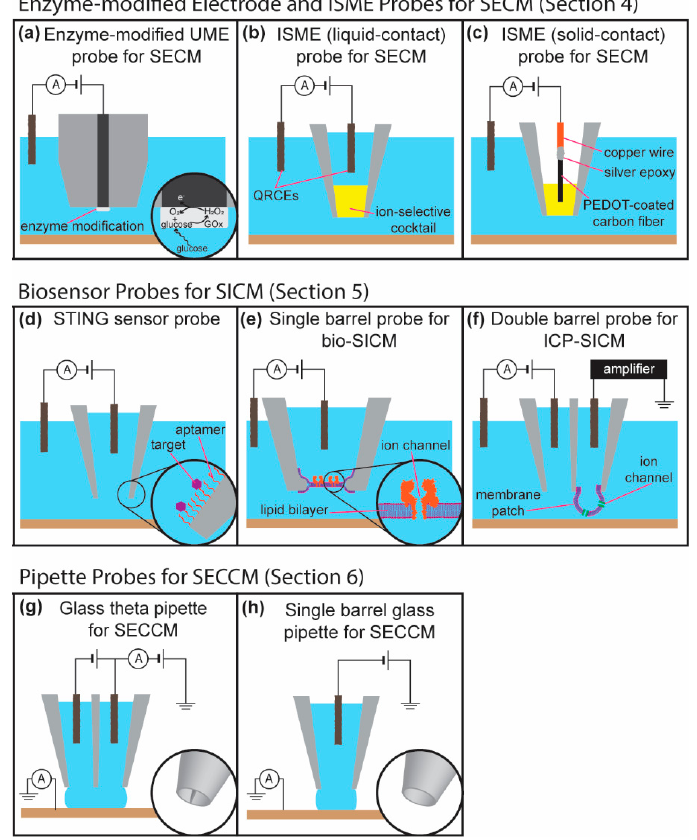
Figure 2. Schematics showing cross-sections of functional probes and droplet-based probes used in SEPM experiments. Insets show either a zoom-in view of the sensing part of biosensor probes or a 3D view of the probe, for clarity. Note that these schematics are not to scale, and configurations are examples of those typically used (with a quasi-reference counter electrode (QRCE) such as Ag/AgCl). Insets show 3D view of the probe, for clarity ( a ) An ultramicroelectrode (UME) can be modified with an enzyme, by electropolymerization or dropcasting, to give chemical specificity to the probe for use in SECM. Inset shows the mechanism of glucose detection using a glucose oxidase (GOx) enzyme layer. ( b ) Ion selective microelectrode (ISME) with a liquid-contact connection. ( c ) ISME with a solid-contact connection. ( d ) A glass nanopipette functionalized with an aptamer to produce a signal transduction by ion nanogating (STING) sensor. ( e ) Single glass pipette filled with electrolyte solution with a suspended lipid bilayer at the tip opening, into which protein ion channels may be reconstituted, used for bio-inspired (bio)-SICM. ( f ) A dual barrel glass pipette, in which both barrels are filled with electrolyte solution and one barrel supports a lipid membrane which has ion channel(s) incorporated, for use as an ion channel probe (ICP) and the second barrel functions as an SICM probe. ( g ) Double barrel theta glass pipette, with both barrels filled with electrolyte solution, connected by a meniscus at the pipette opening that creates an electrochemical cell at the substrate surface, used for scanning electrochemical cell microscopy (SECCM). ( h ) Single barrel glass pipette, filled with electrolyte solution, connected by a meniscus at the pipette opening that creates an electrochemical cell when in contact with the substrate surface, used for SECCM. Noteworthy additions to the SEPM literature in the last five years include the application of novel and multifunctional electrochemical imaging probes, pushing the limits of spatial resolution